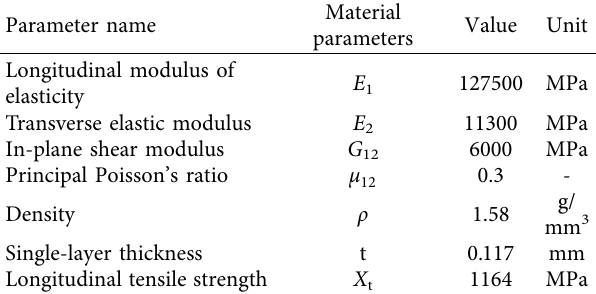
Table 1: Material parameters of AS4-3502.